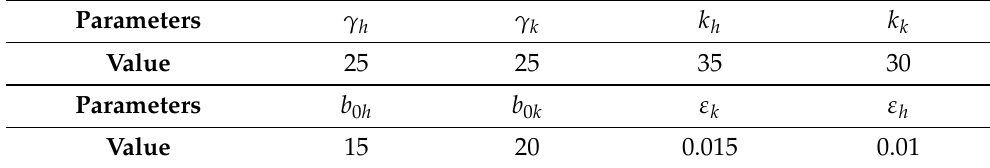
Table 1. LESO-based controller’s parameters.